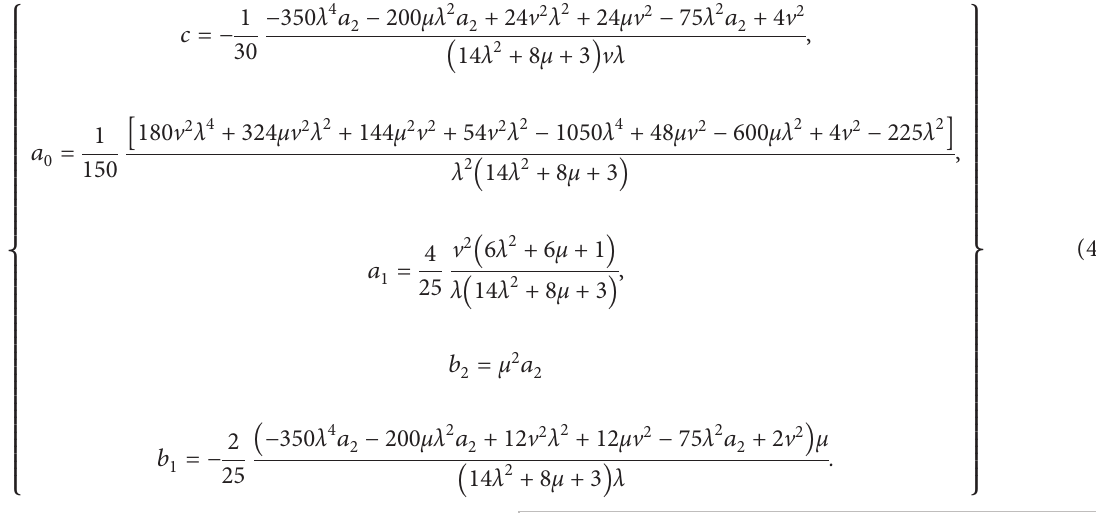
Figure 3: The two-dimensional representation of solution (19) when λ �